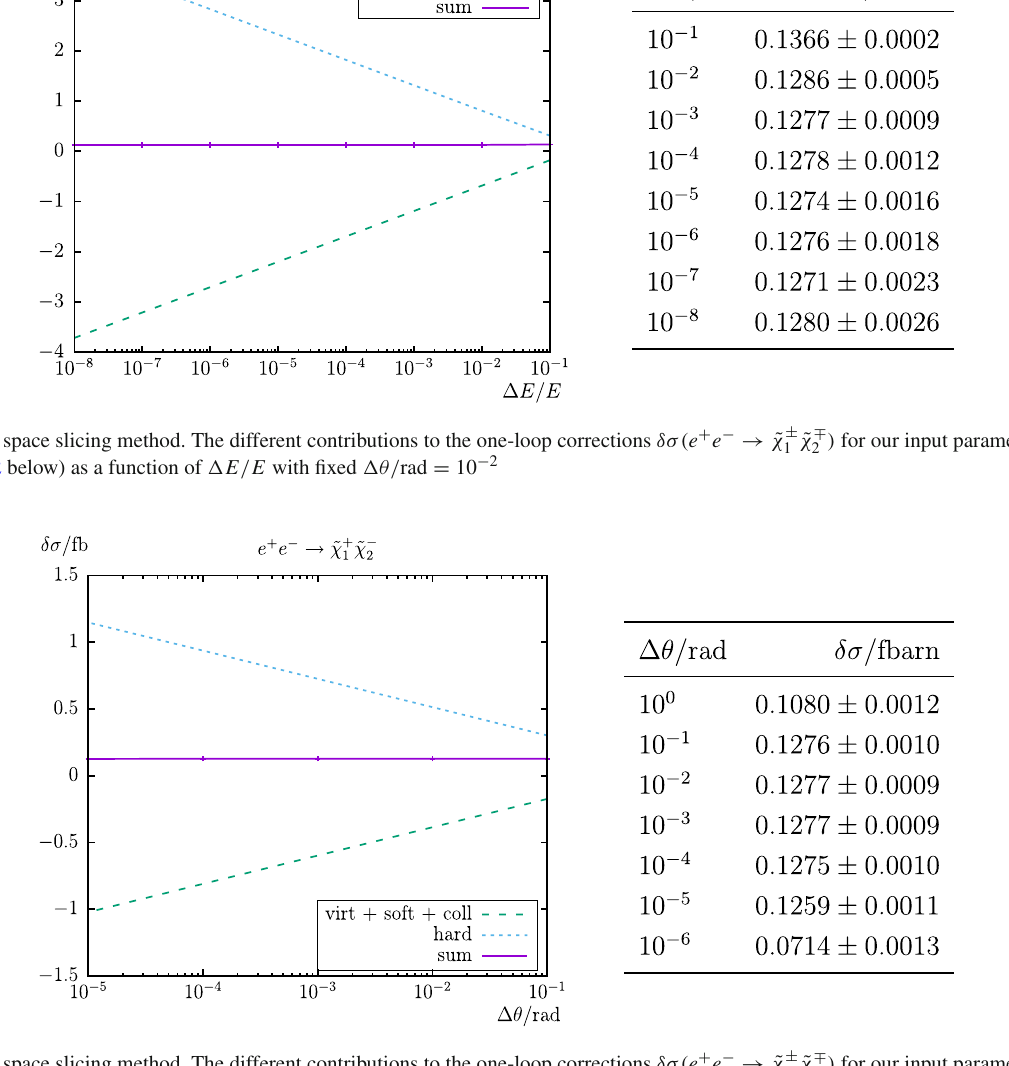
Fig. 4 Phase space slicing method. The different contributions to the one-loop corrections δσ( e + e − → ˜ χ ± S (see Table 2 below) as a function of (cid:7)θ/ rad with fixed (cid:7) E / E = 10 −